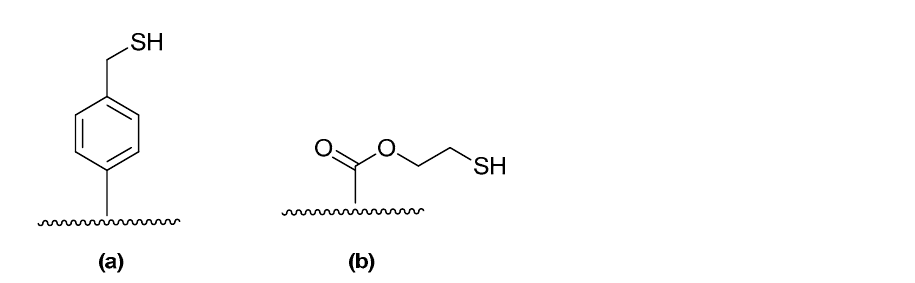
Figure 2. Structure of the supports for the Pd NPs used in this work: ( a ) styril thiol-grafted polyolefin fiber (Smopex ® -111); ( b ) mercaptoethyl acrylate-grafted polyolefin fibers (Smopex ® - 234).